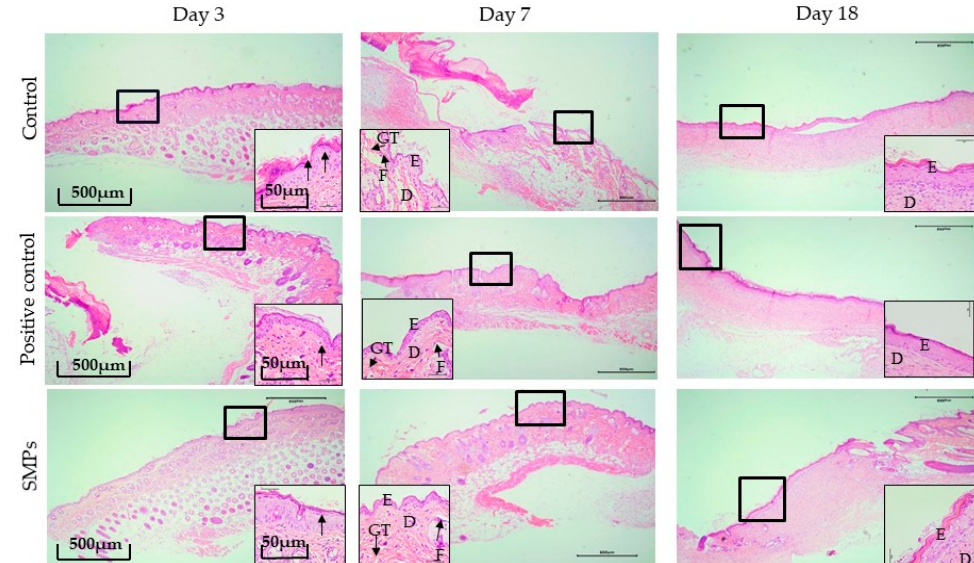
Figure 4. H&E stain histological analysis (4X). Note: The black bold frame indicates the wound site, and the picture at the bottom corner of the picture shows a magnified image of the wound (40X). On the third day, black arrows indicate inflammatory cell infiltration. The letters D , E , F , and GT represent the dermis layer, the epidermal layer, fibroblasts, and granulation tissue, respectively. Molecules 2019 , 24 , x